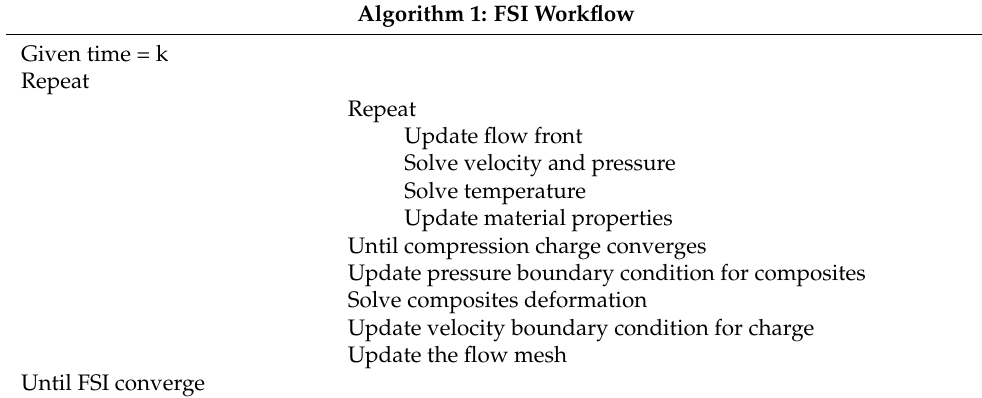
Table 1. Complete FSI workflow.